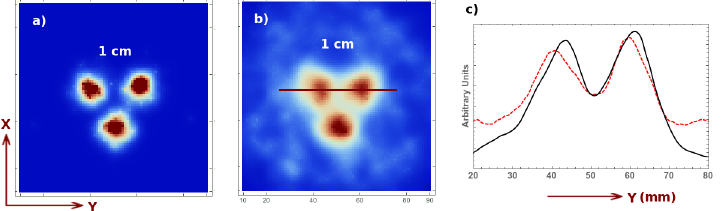
Figure 10. Image reconstruction for a 1.8 s acquisition of a 1 cm Derenzo and 0.1 Mbq activity for each sphere, at 5 cm from the collimator, without background ( a ), with background ( b ) (8:1 signal to background ratio) and its profile ( c ) for the current acquisition (solid black curve) and for the previous acquisition (red dashed curve).